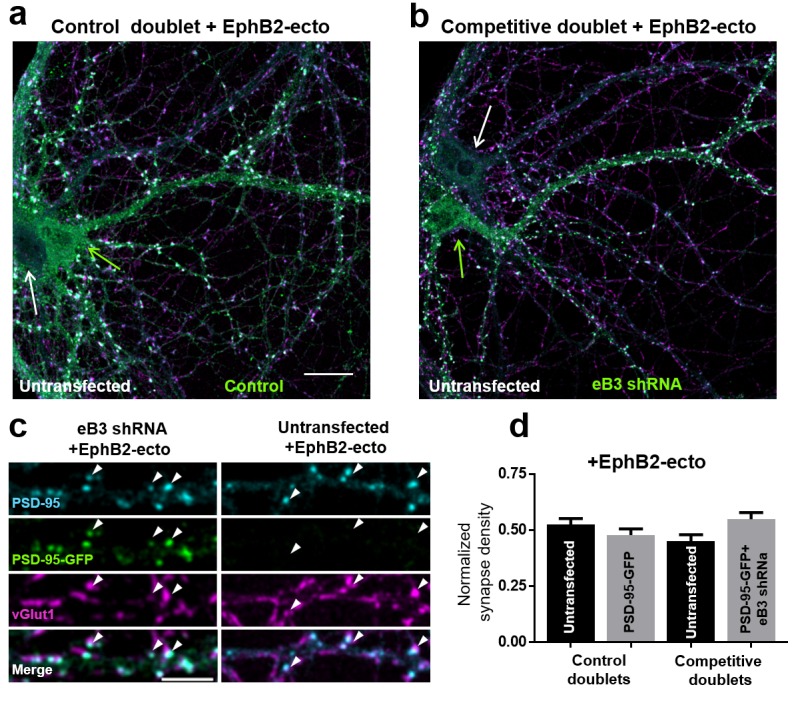
Unclustered EphB2 ectodomain blocks competition in microislands.(a and b) Representative images of control (a) and competitive (b) doublets treated with 500 ng/ml (250 ng/well) of unclustered EphB2 ectodomain. Scale bar, 20 μm. (c) Higher magnification images of dendrites in a competitive microisland treated with EphB2 ectodomain. Scale bar, 5 μm. (d) Quantification of the fraction of total synapse density on neurons within control and competitive doublets treated with EphB2 ectodomain (Control doublets, n = 7 for untransfected and PSD-95-GFP cells (one experiment); competitive doublets, n = 9 for untransfected and eB3 shRNA cells (three experiments); F(3, 28)=2.485, p=0.0813 one-way ANOVA.10.7554/eLife.41563.014Figure 4—figure supplement 2—source data 1.EphB2 ectodomain blocks competition in microislands.